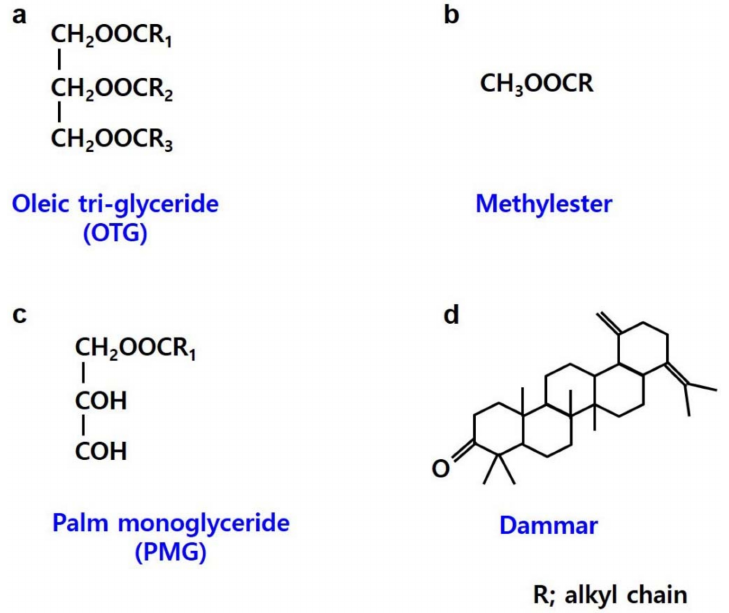
Figure 1. Schematic diagram of diverse oils ( a ) Schematic diagram of palm oil (oleic tri-glyceride). ( b ) Schematic diagram of methylester oil. ( c ) Schematic diagram of palm monoglyceride oil. ( d ) Schematic diagram of dammar oil.